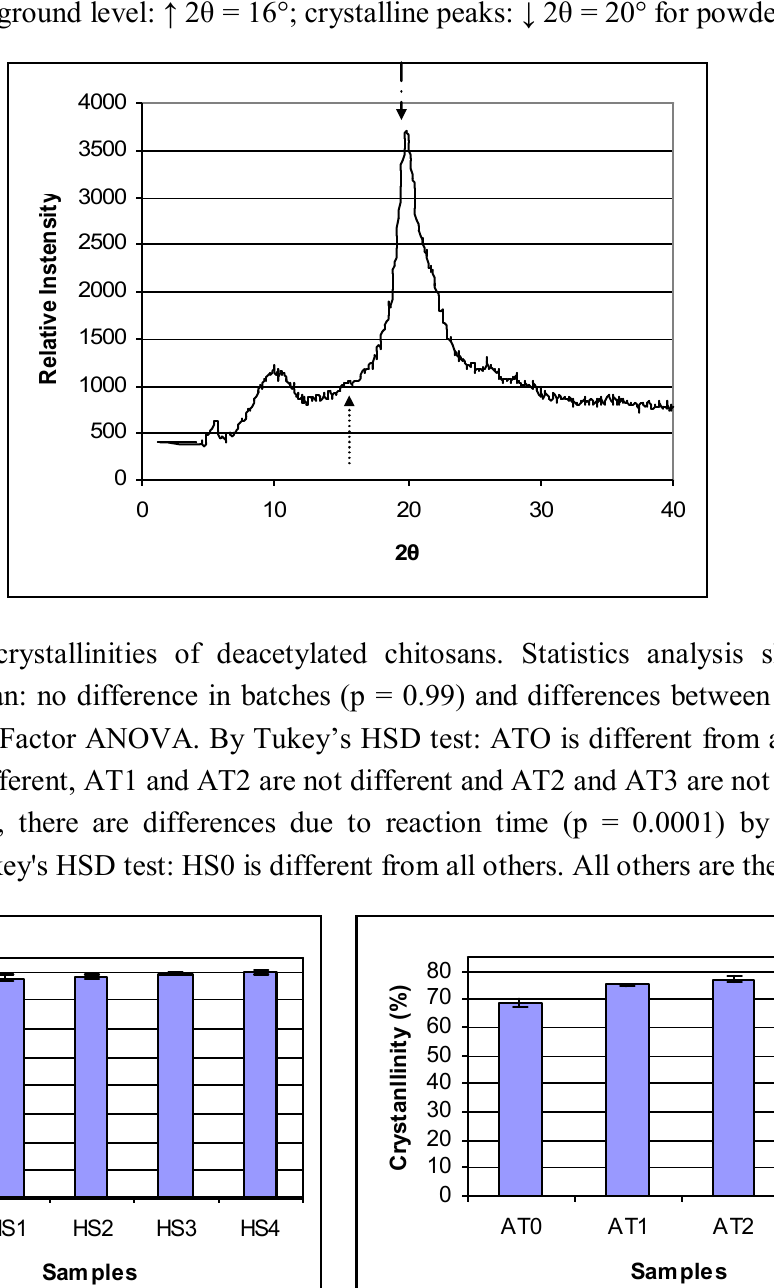
Figure 1. X-ray diffraction pattern. The HS0 72.6% DDA chitosan powder Diffractogram is representative of the other chitosan materials evaluated in this study. Peaks at 2θ ~ 10° and 20° are indicative of hydrated, partially crystalline materials. Arrows indicate amorphous background level and crystalline peaks used to calculate crystallinity index